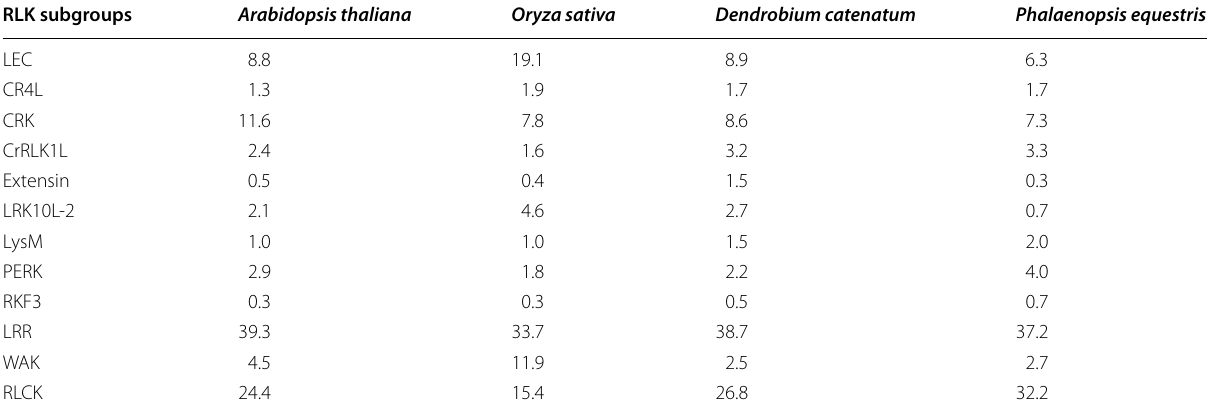
Table 2 Proportion of Arabidopsis , Oryza and orchid sequences belonging to RLK subgroups RLK subgroups Arabidopsis thaliana Oryza